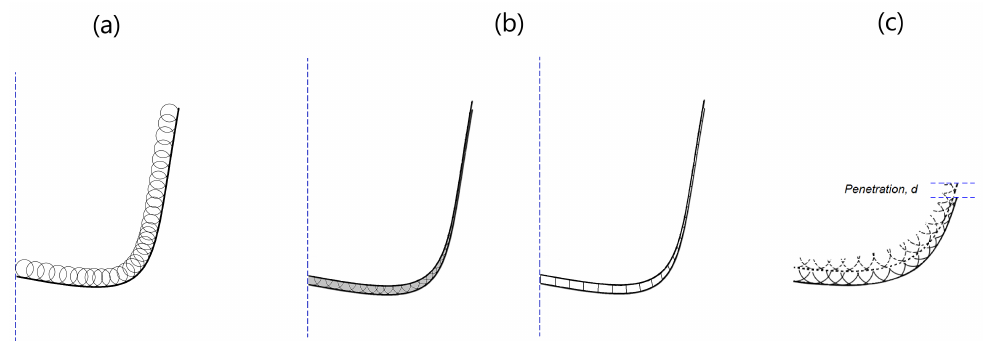
Figure 6. ( a ) Traces of all cutters on a vertical plane. ( b ) Equivalent blade produced by traces of cutters involved in drilling depth, d , in one revolution and discretization of equivalent blade into equivalent rectangular cutters. ( c ) Spatial position of cutters in two successive